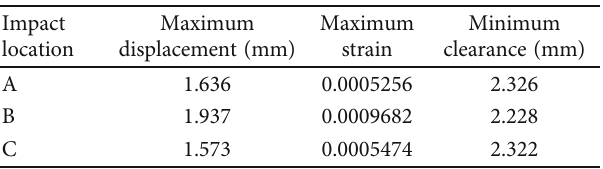
Figure 13: Di ff erent impact points. Strain clouds of bird impact battery box at di ff erent impact points. Strain clouds of battery boxes at di ff erent bird impact points. (a) Impact point A. (b) Impact point B. (c) Impact point C. Table 10: Response of battery box under bird impact at di ff erent impact